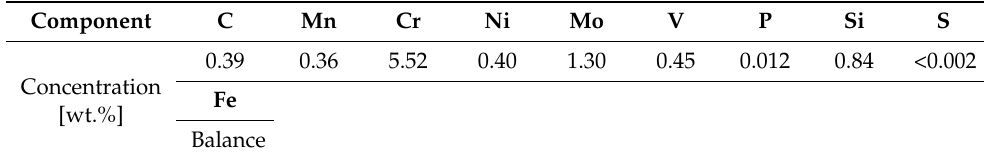
Table 1. Chemical composition of the hot-work tool (X37CrMoV5-1) steel [15]. Component C